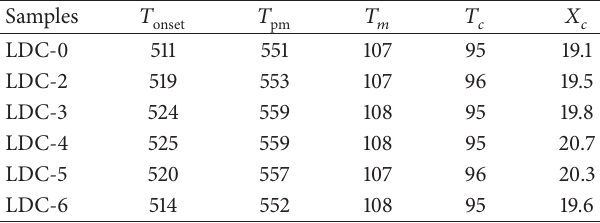
Table 4: DSC results of the nanocomposites film [42]. Samples